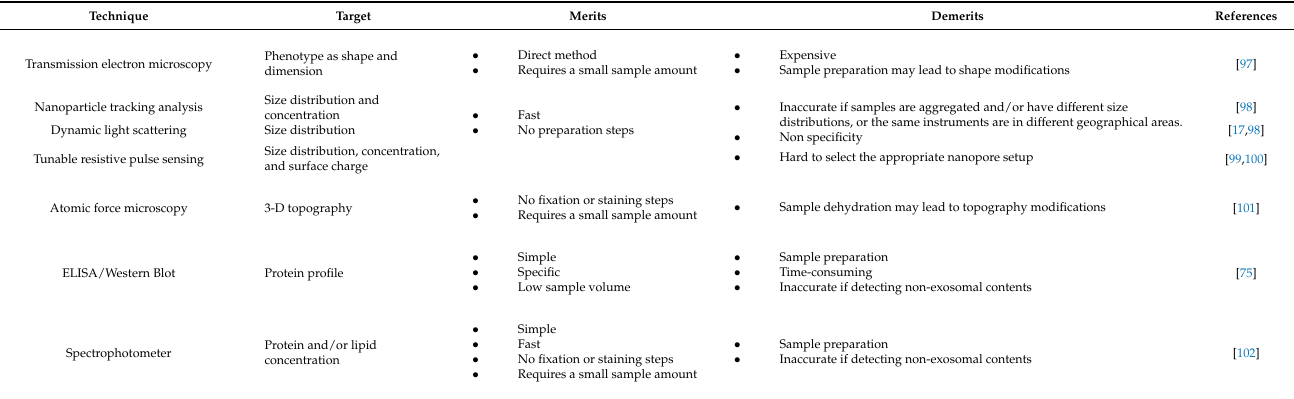
Table 2. Physical and chemical characterization techniques for exosomal